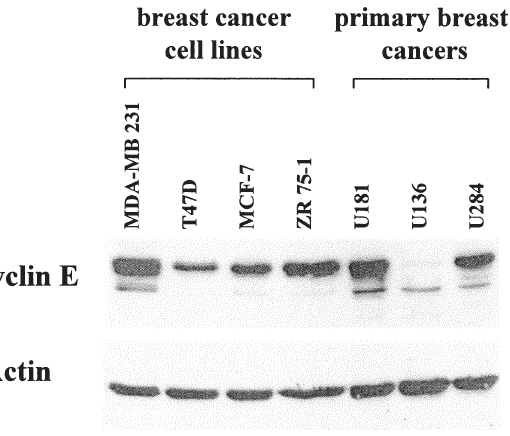
Fig. 1B. Cyclin E and actin Western blotting analysis of breast cancer cell lines MDA-MB 231, T47D, MCF-7, and ZR-75-1 (lane 1–4) and three primary breast cancers U181, U136, and U284 (lane